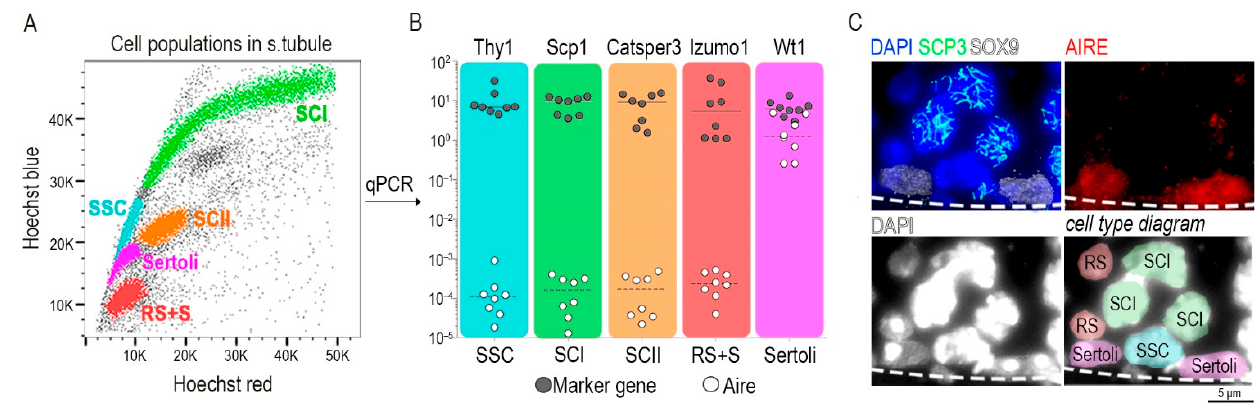
Figure 2. Sertoli cells express Aire ‐ coding mRNA. ( A ) The cell population from within the seminif ‐ erous tubule was stained with Hoechst 33342 and visualized in Hoechst red and blue channels. A color code was applied to the following cell types: turquoise spermatogonia stem cell (SSC), green primary spermatocytes (SCI), orange secondary spermatocytes (SCII), red round spermatids and sperm (RS+S), magenta Sertoli cells (Sertoli). ( B ) A single cell suspension from ( A ) was FACS ‐ sorted and the indicated cell ‐ types were prepared for mRNA isolation and qRT–PCR. Only Sertoli cells expressed physiologically relevant levels of Aire mRNA. The y axis represents the relative transcript levels of Aire and marker genes normalized to the Casc3 gene. ( C ) Protein immunodetection on the testicular tissue ‐ sections showed the localization of AIRE in the nuclei of Sertoli cells (upper right panel) identified by their positivity to SOX9 (white color, upper left panel). SCP3 is a marker of primary spermatocytes (SCI). Spermatogonia stem cells (SSC), typically positioned between two Sertoli cells at the base of seminiferous tubule and round spermatid (RS), are identified as DAPI + SOX9 – SCP3 – , exhibiting a typical nuclear morphology [49] . The dashed line demarcates the edge of the seminiferous tubule. Cell types within the diagram (lower right panel) correspond to the color scheme used in qPCR.